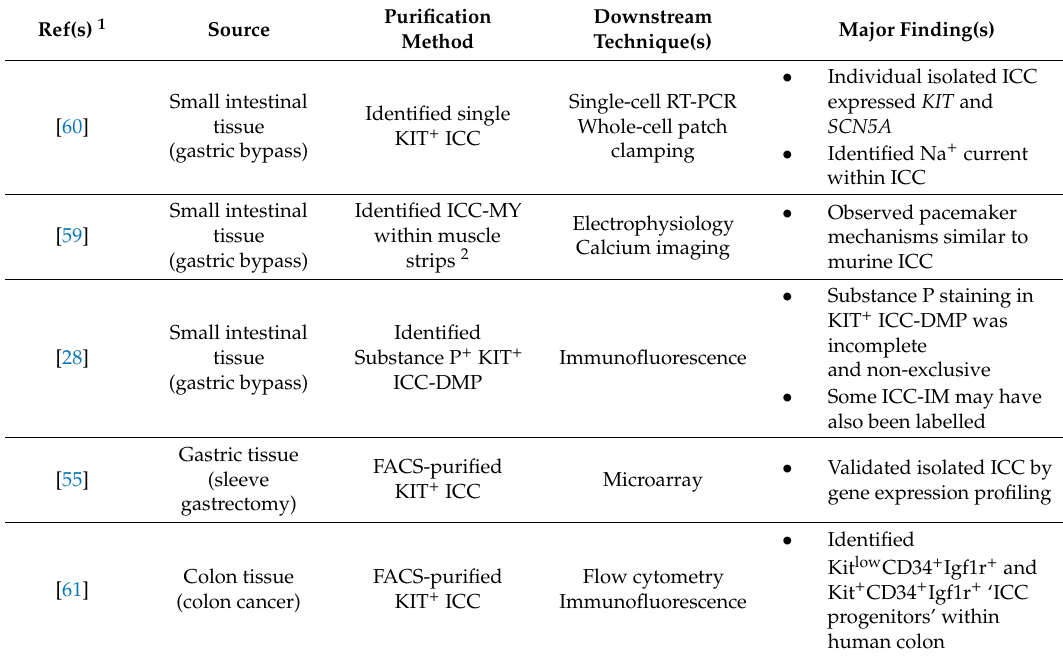
Table 2. Key molecular characterisation studies using interstitial cells of Cajal (ICC) isolated from human GI